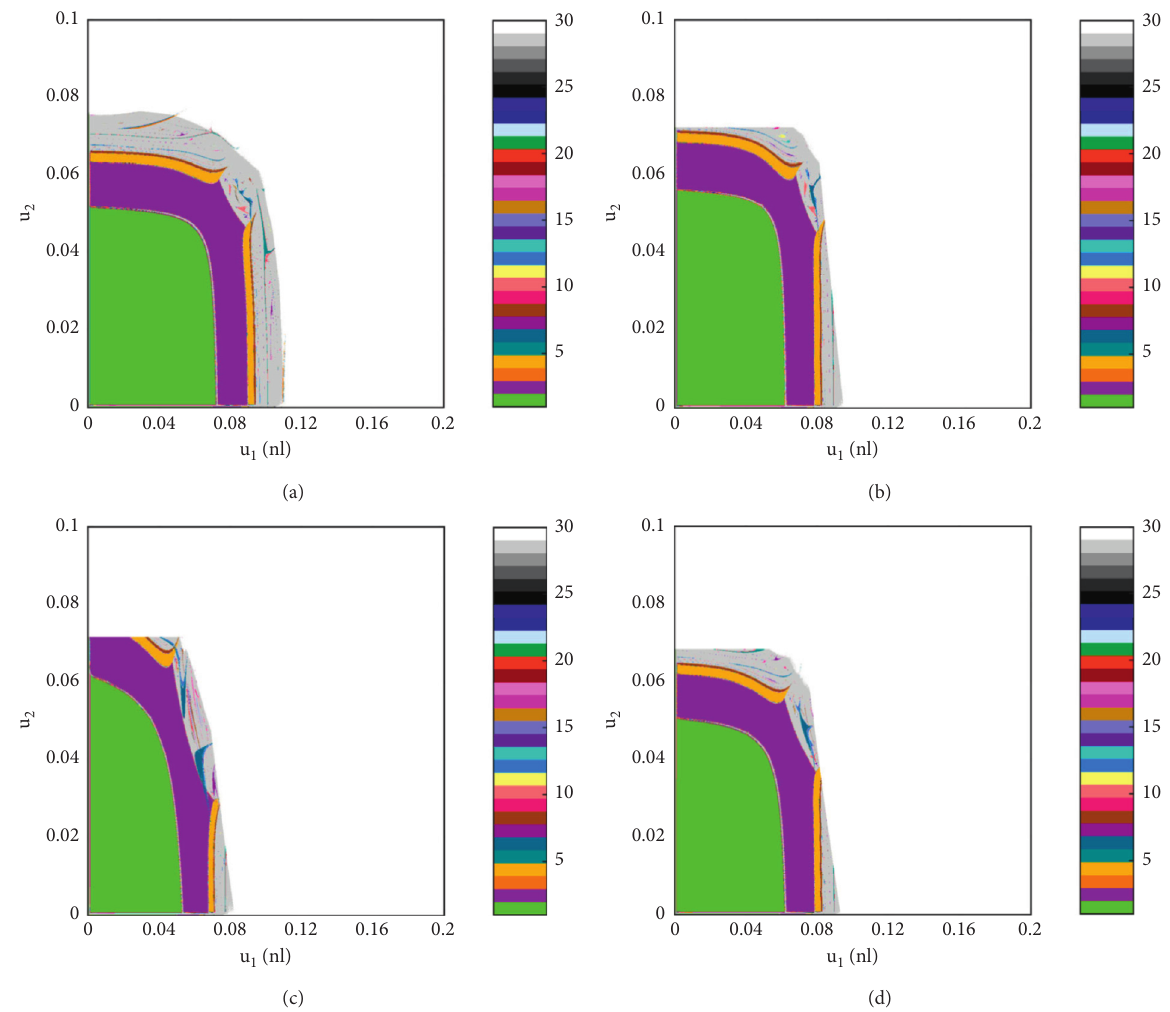
Figure 6: The 2-D bifurcation diagram of system (10). (a) α � 0 . 3 ,p and (d) α � 0 . 5 , p c � 1 , β � 0 .